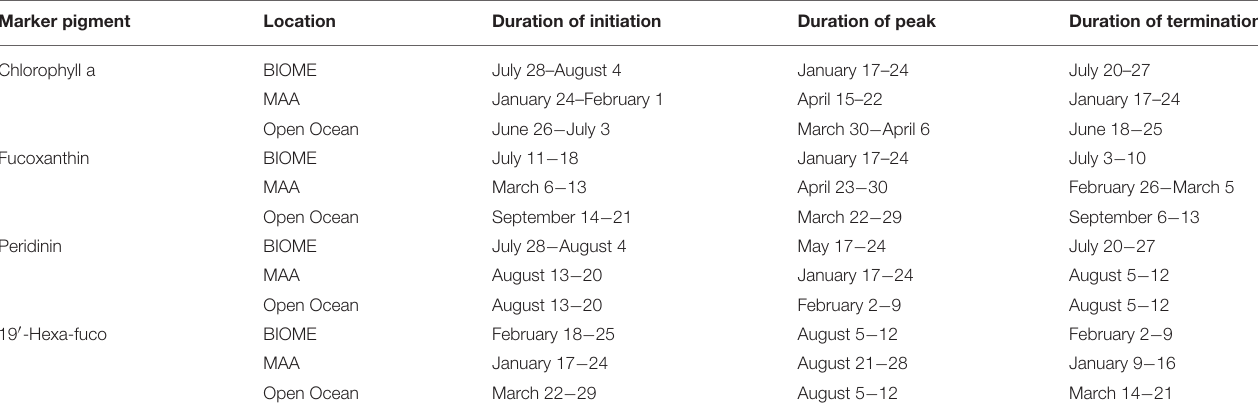
TABLE 4 | Phenology of certain PFT markers in the study region for 2006 as defined by the dates of the initiation, peak and termination of the seasonal maximum/bloom period. Marker